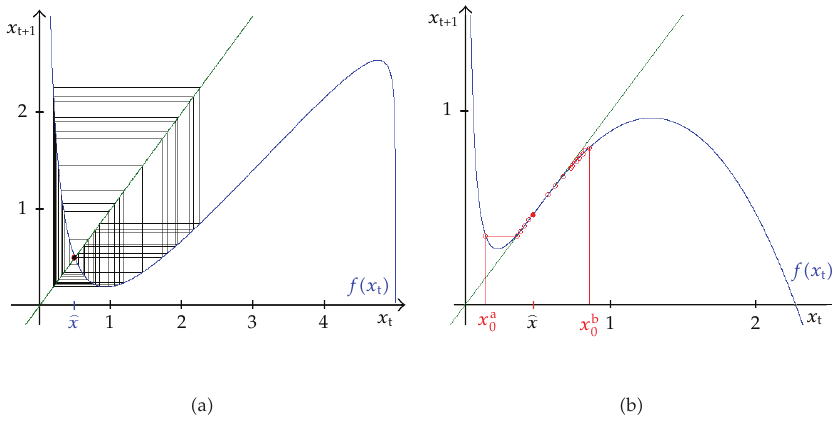
Figure 4: (cid:2) a (cid:3) obtained with this set of parameters: m (cid:8) 7 ,p (cid:8) 1 . 4 ,α (cid:8) 0 . 1 ,γ (cid:8) 1 . 276 the optimal choice (cid:4) x is unstable and the dynamics are chaotic. (cid:2) b (cid:3) the reactivity parameter γ is endogenous and there is convergence both starting from an initial condition lower (cid:2) x a